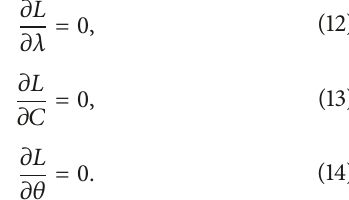
where the point (𝑥 𝑖 , 𝑦 𝑗 , 𝑧 𝑘 ) satisfies 𝑥 𝑟 < 𝑥 𝑖 < 𝑥 𝑟+1 , 𝑦 𝑚 < 𝑦 𝑗 < 𝑦 , 𝑧 < 𝑧 < 𝑧 𝑚+1 𝑙 𝑘 𝑙+1 . And the meanings of Figure